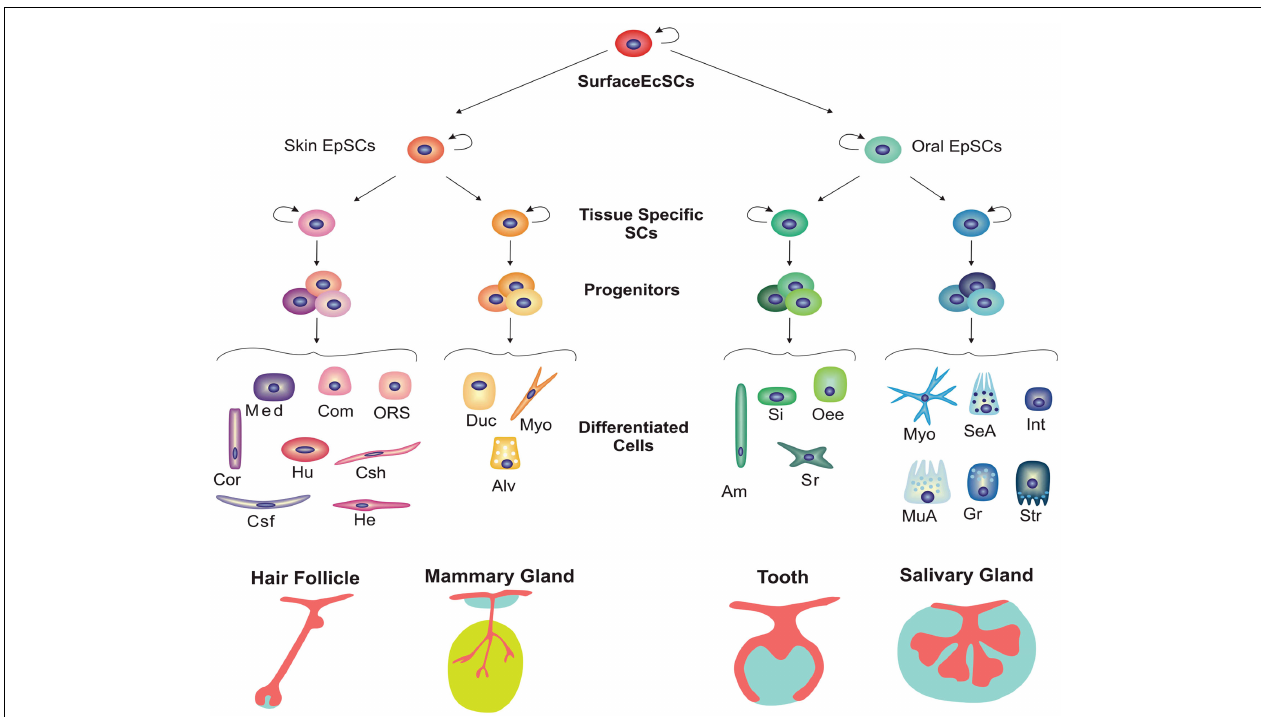
populations. Abbreviations: Alv, alveolar cell; Am, ameloblast; Com, companion layer; Cor, cortex; Csf, cuticle of the hair shalf; Csh, cuticle of the